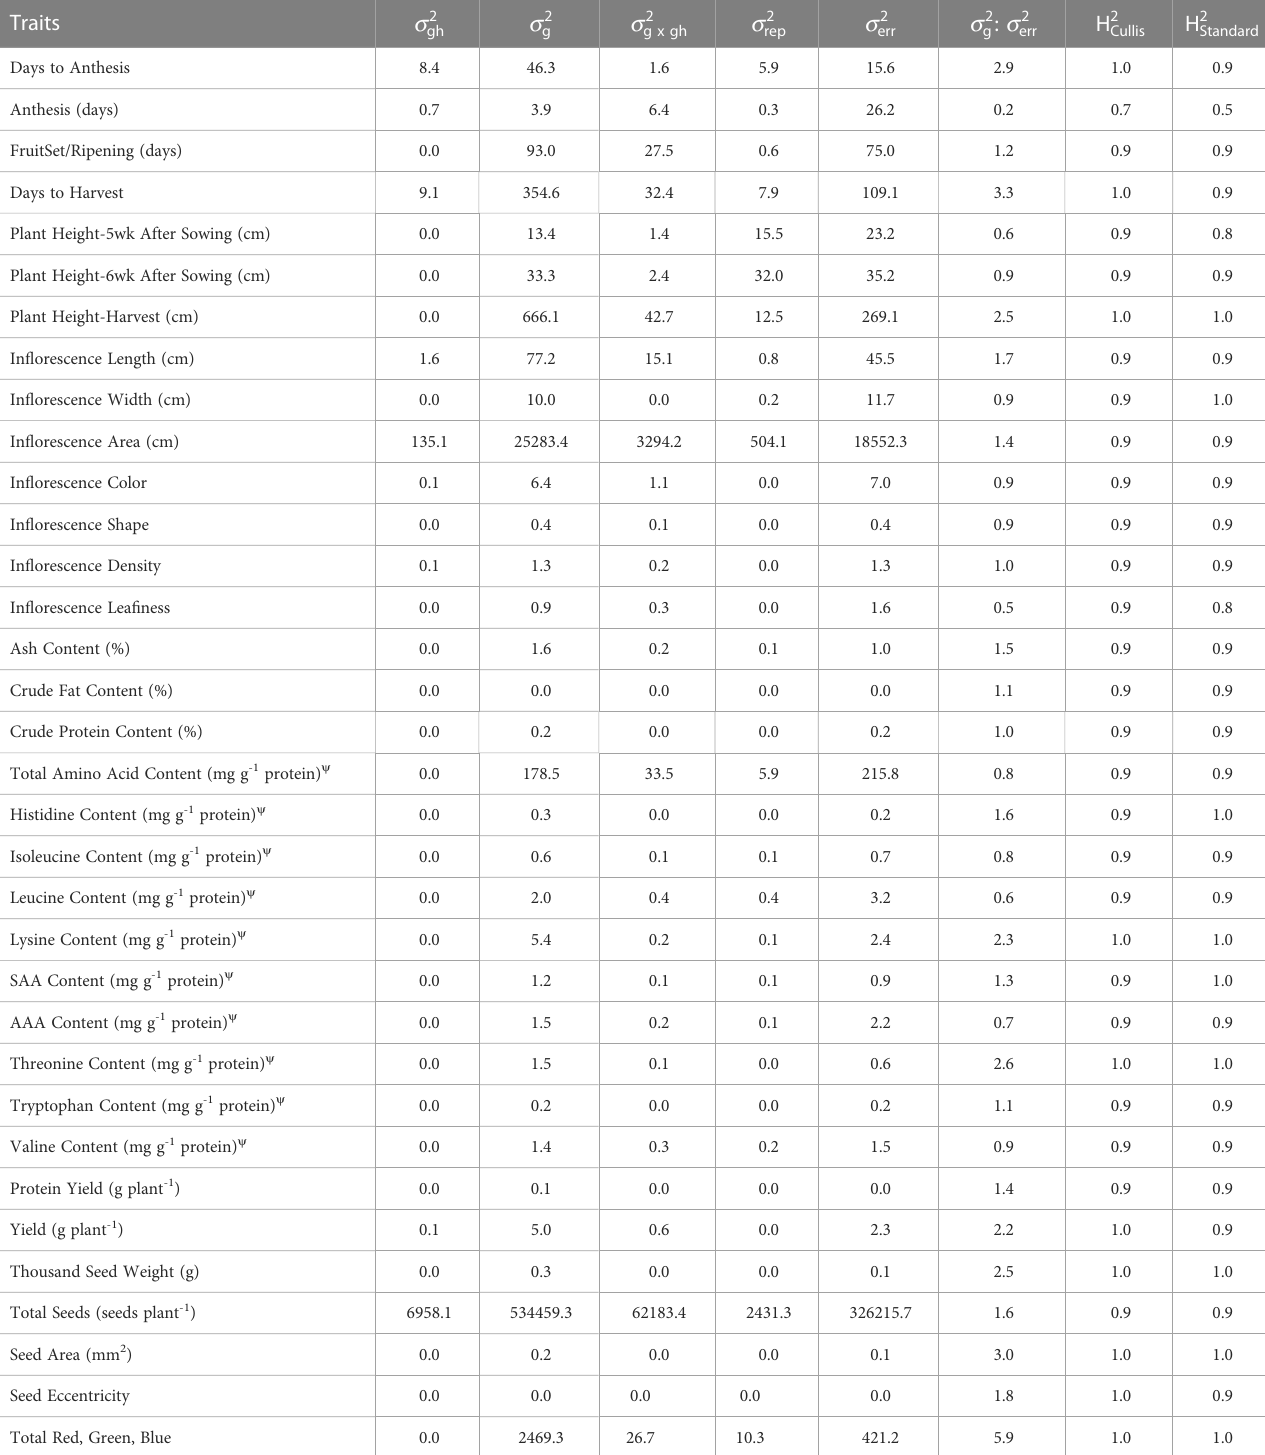
TABLE 7 Variance components for each trait, including accession by greenhouse interaction ( s 2 g x gh), accession ( s 2 g ), replicate ( s 2 rep ), greenhouse ( s 2 gh ), residual ( s 2 err ), and the ratio of accession variance to residual variance ( s 2 gh : s 2 err ), in addition to Cullis heritability ( H 2 Cullis ) and standard heritability ( H 2 Standard ).